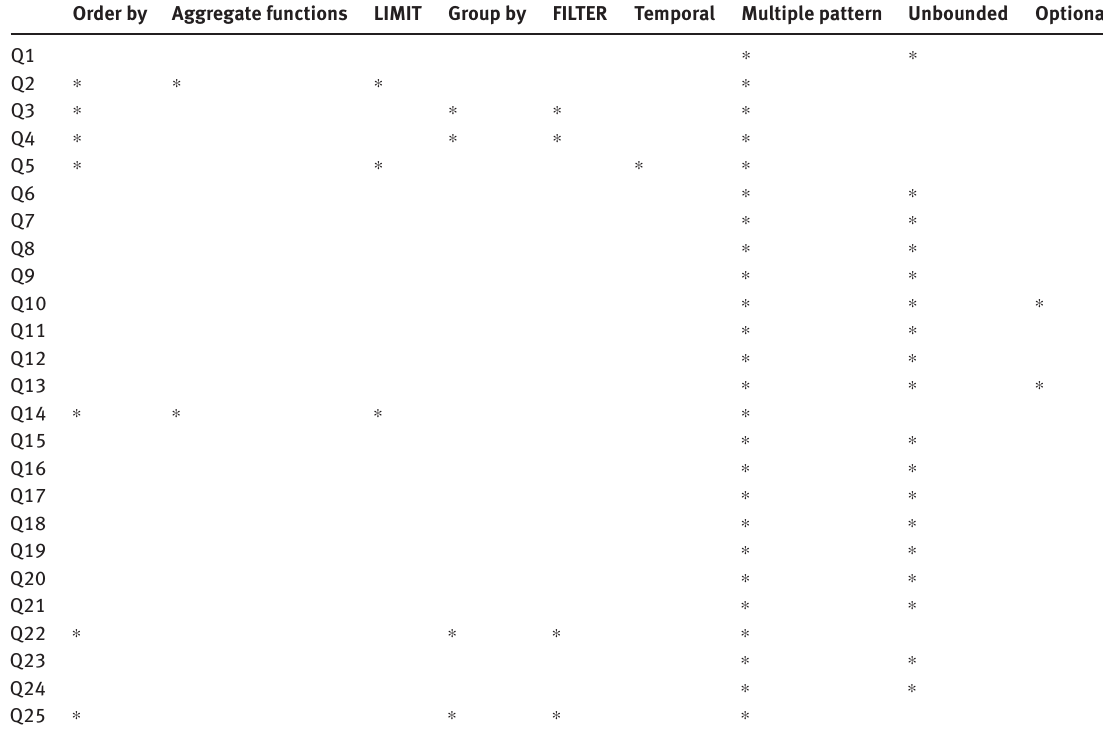
Table 3: Mapping of Various SPARQL Query Constructs to Semantic Queries. Order by Aggregate functions LIMIT Group by FILTER Temporal Multiple pattern Unbounded